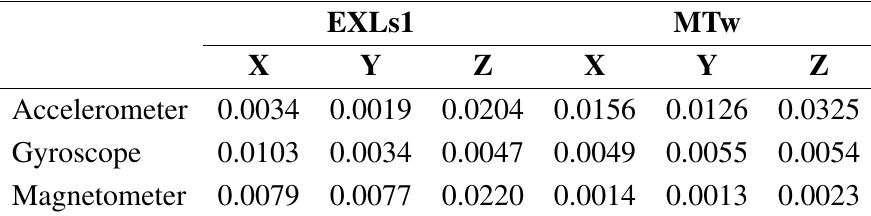
Table 2. Static noise estimation for the different sensors of the EXEL and Xsens sensing